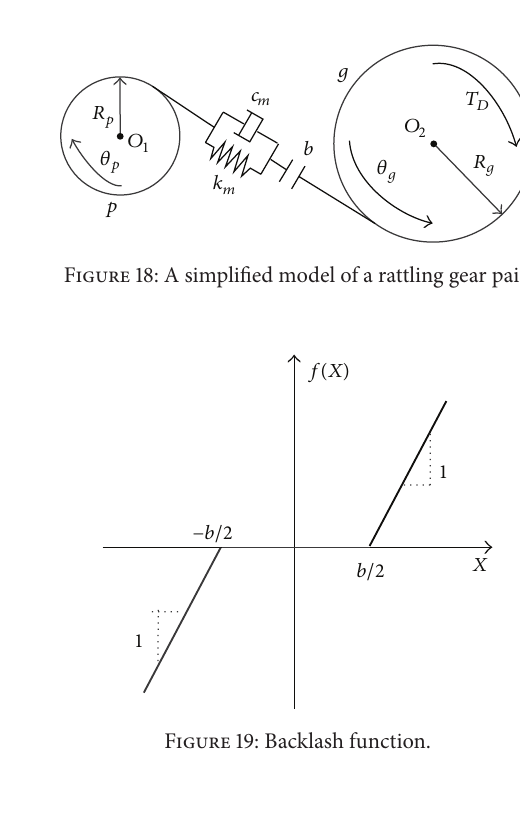
Figure 8. So rattling force of unloaded gear pair is